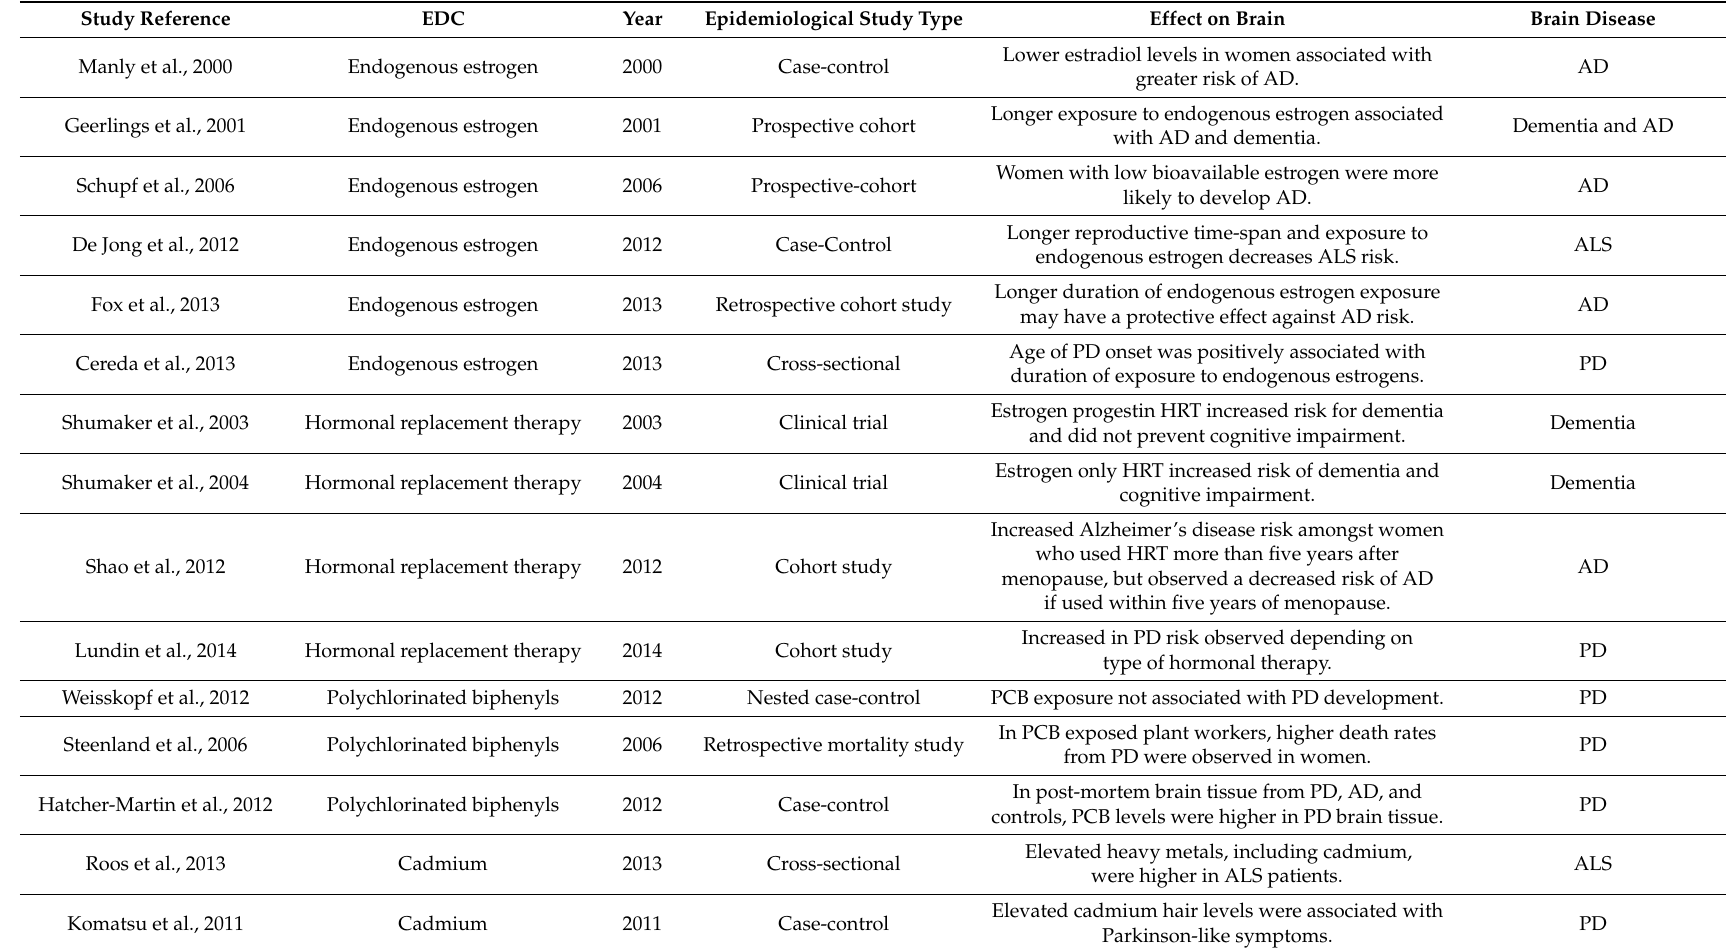
Table 1. Epidemiological studies summarizing association between endogenous estrogen, hormonal replacement therapy, phthalates, polychlorinated biphenyls, cadmium, arsenic and manganese and neurodegenerative diseases—Alzheimer’s disease (AD), Parkinson’s disease (PD), amyotrophic lateral sclerosis (ALS), and